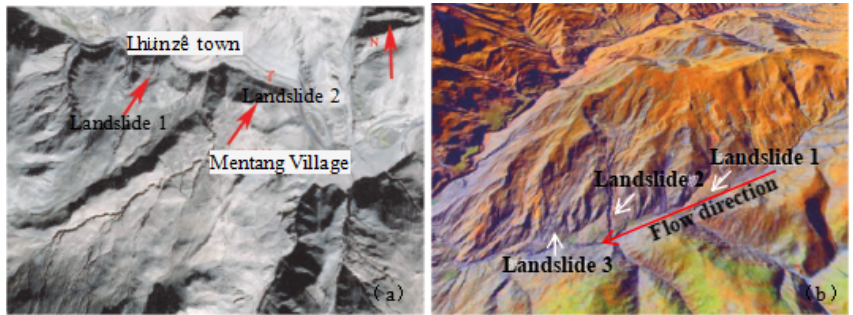
Figure 4. Remote sensing map of landslides in Lhünzê township (Tong et al., 2019): (a) landslides in Lhünzê town and (b) landslides in Malu